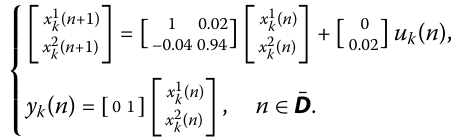
Figure 6 Tracking error tendency in discrete-time